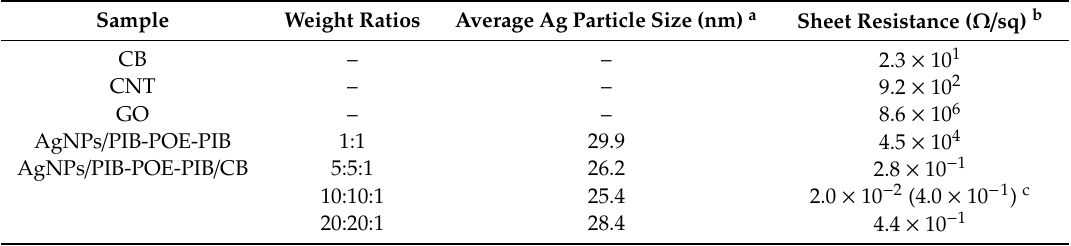
Figure 4. Transmission electron microscope ( TEM) images of colloidal AgNPs in complexes with different weight ratios of AgNO3, PIB-POE-PIB, and carbon-based nanomaterials. ( a ) AgNO3/PIB-POE-PIB/CB, ( b ) AgNO3/PIB-POE-PIB/CNT, and ( c ) AgNO3/PIB-POE-PIB/GO reductions with weight ratios of (1) 5:5:1, (2) 10:10:1, and (3) 20:20:1. Table 1. Particle size, sheet resistance, and mechanical stability of AgNPs / PIB-POE-PIB / carbon-based nanomaterials